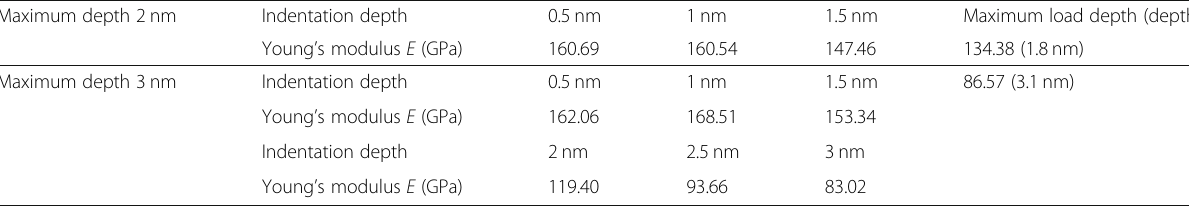
Table 4 Young ’ s modulus of single crystal copper during nano-indentation with subsurface